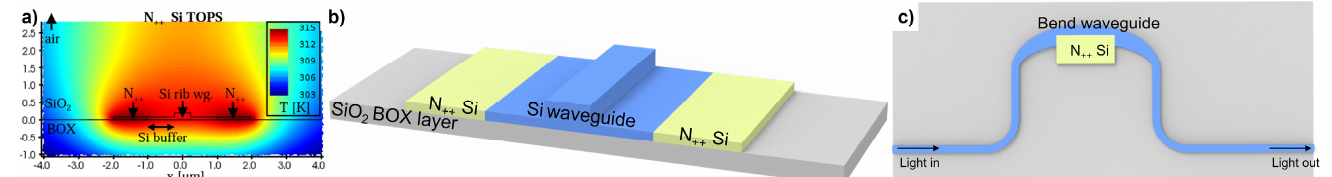
Figure 8. ( a ) Steady-state heat distribution for rib waveguide with doping silicon heaters, ( b ) rib waveguide thermo-optics phase shifter, ( c ) bended thermo-optics phase shifters with doping silicon heaters embedded in an MZI.